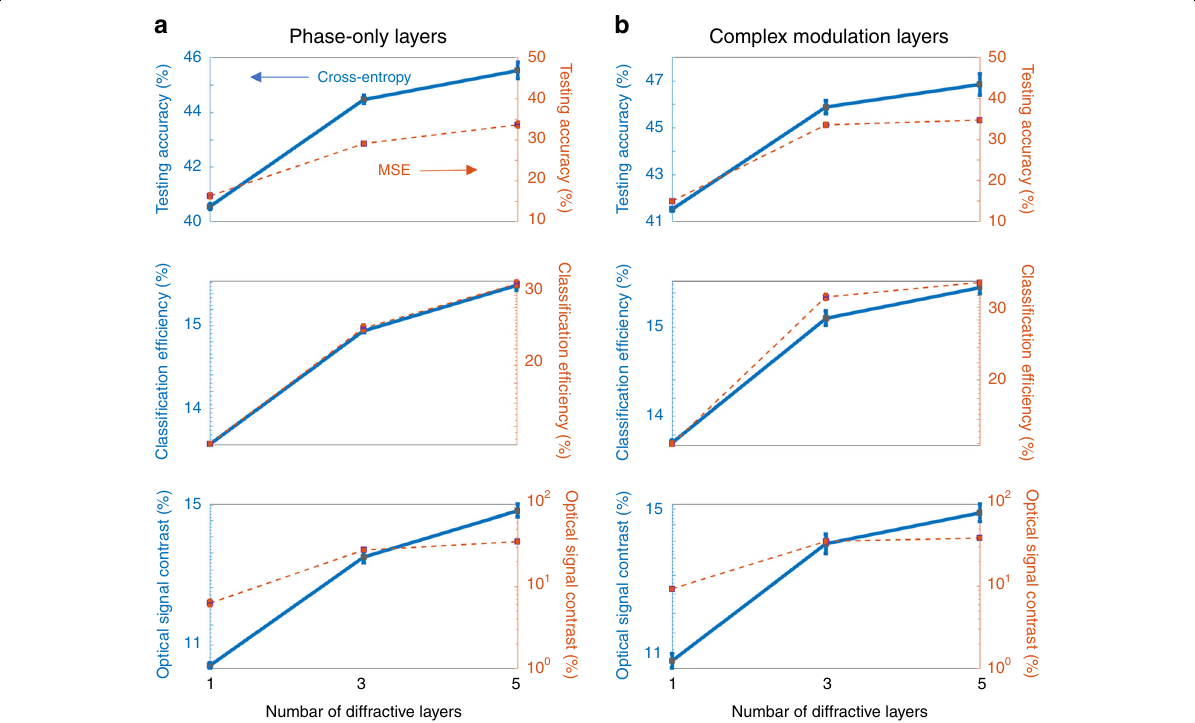
Fig. 6 Comparison of the 1-, 3-, and 5-layer diffractive networks trained for CIFAR-10 image classi fi cation using the MSE and cross-entropy loss functions. a Results for diffractive surfaces that modulate only the phase information of the incoming wave. b Results for diffractive surfaces that modulate both the phase and amplitude information of the incoming wave. The increase in the dimensionality of the all-optical solution space with additional diffractive surfaces of a network brings signi fi cant advantages in terms of generalization, blind-testing accuracy, classi fi cation ef fi ciency, and optical signal contrast. The classi fi cation ef fi ciency denotes the ratio of the optical power detected by the correct class detector with respect to the total detected optical power by all the class detectors at the output plane. Optical signal contrast refers to the normalized difference between the optical signals measured by the ground-truth (correct) detector and its strongest competitor detector at the output